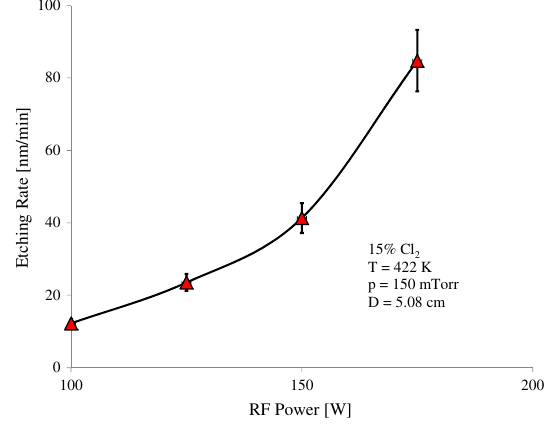
FIG. 8. Etching rate dependence on the gas pressure. Solid line is visual guideline.